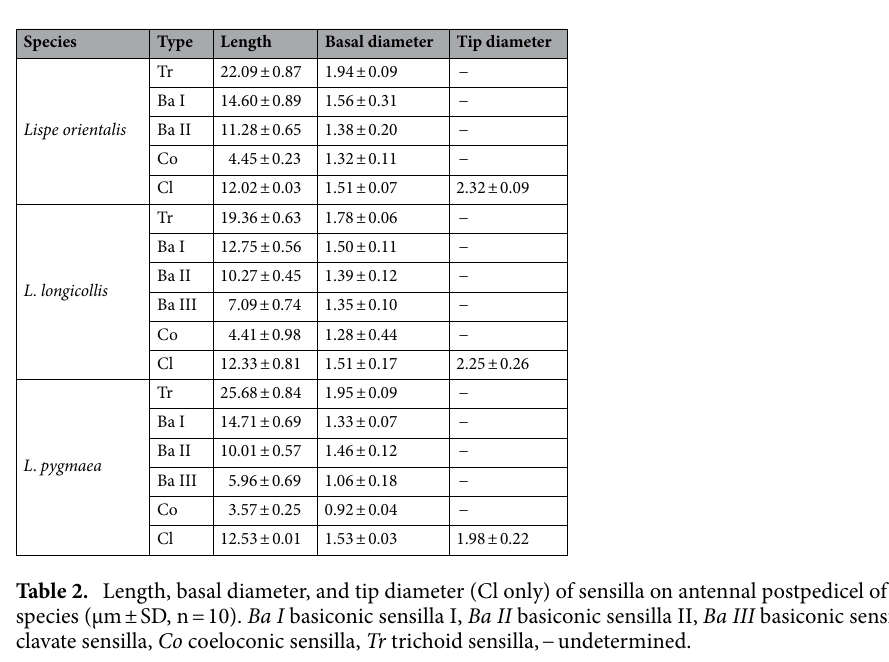
Figure 7. Two-way ANOVA results of characters of maxillary palps among three Lispe species and sexes. ( a ) Swelling degree of maxillary palps of the three species among three species and sexes. Male L. orientalis has significantly larger swelling than females ( F 5,24 = 39.99, P < 0.001; species: F 2,24 = 77.05, P < 0.001; sex: F 1,24 = 18.96, P < 0.001; species × sex: F 2,24 = 13.44, P < 0.001). ( b ) The ratio of maxillary palp length to body length (LMP/ BL) among three species and two sexes. Male L. orientalis has significantly longer maxillary palps than females ( F 5,24 = 3.98, P = 0.0090; species: F 2,24 = 3.49, P = 0.05; sex: F 1,24 = 1.41, P = 0.25; species × sex: F 2,24 = 5.75, P = 0.0091). ( c ) The ratio of maxillary palp width to body length (WMP/BL) among three species and two sexes. Male L. orientalis has significantly wider maxillary palps than females ( F 5,24 = 63.58, P < 0.001; species: F 2,24 = 111.78, P < 0.001; sex: F 1,24 = 34.23, P < 0.001; species × sex: F 2,24 = 1.26, P < 0.001). Different lower-case letters mean significant differences.